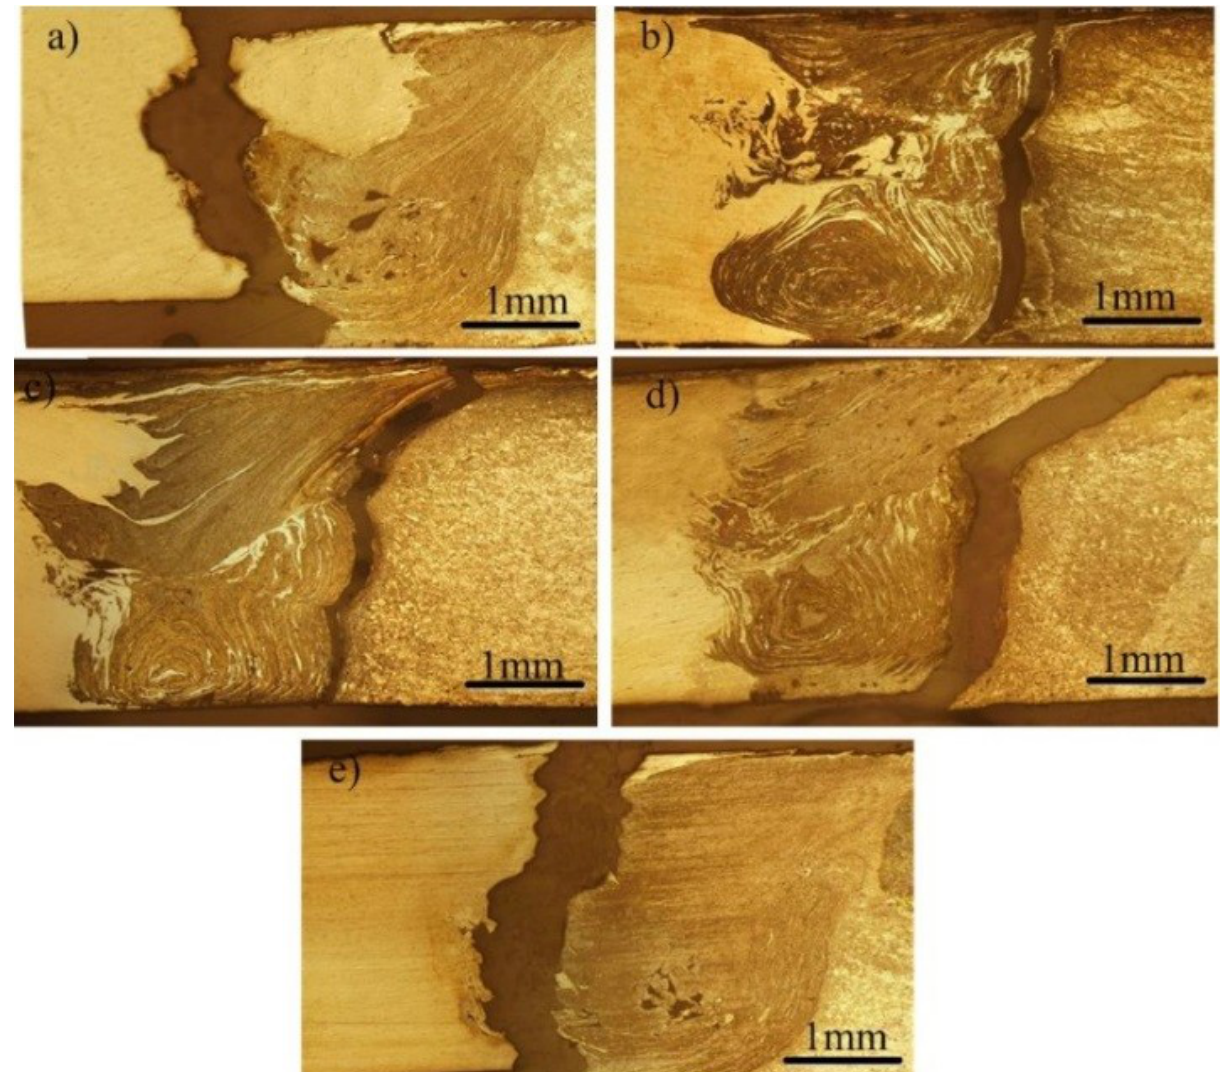
Figure 9: Fracture locations of the joints by different welding speeds: (a) 30 mm/min, (b) 40 mm/min, (c) 50 mm/min, (d) 60 mm/min and (e) 70